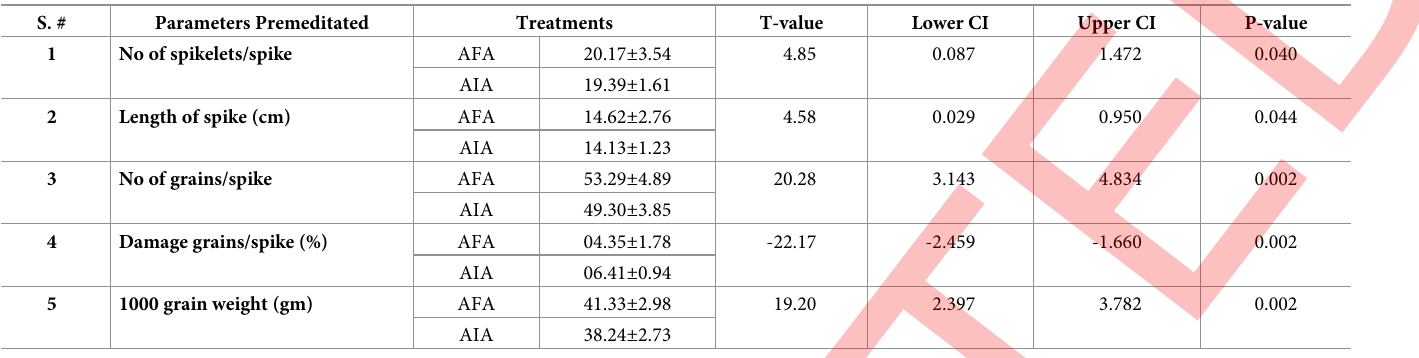
Table 2. The assessment of losses caused by different aphid species in yield related traits of wheat crop (n = 300). S. #